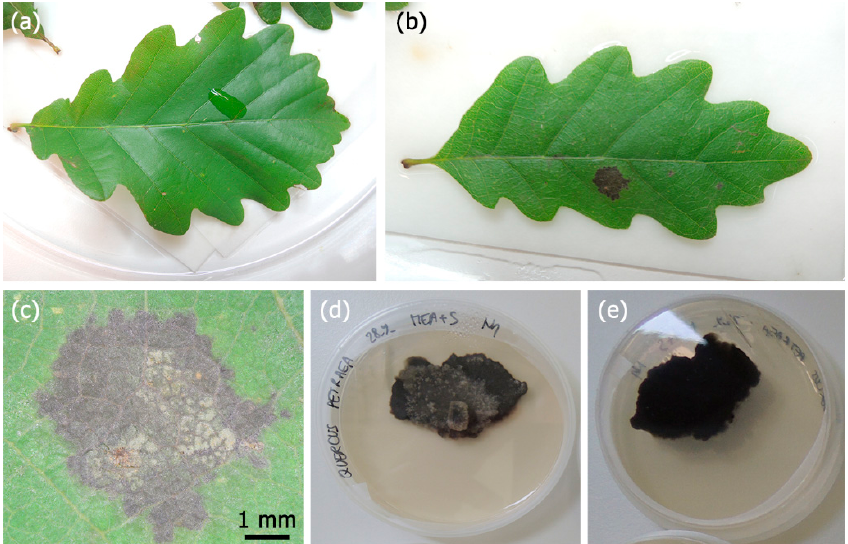
Figure 5. Pathogenicity test on Quercus petraea : ( a ) Control on the 21st day; ( b ) necrotic leaf spot on the 21st day; ( c ) disintegration of the inoculated propagule on the 21st day; ( d , e ) upper and reverse side of culture re-isolated from necrotic leaf spot on MEA, respectively.